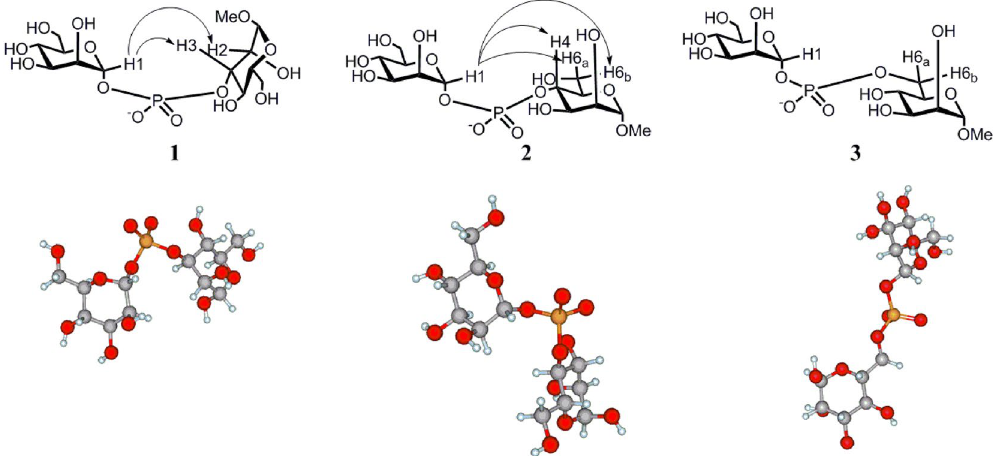
Figure 4. Illustration of the observed NOEs (shown by arrows) in compounds 1 - 3 upon pre-irradiation of the H1 ′ proton in the glycosylating residue at 303